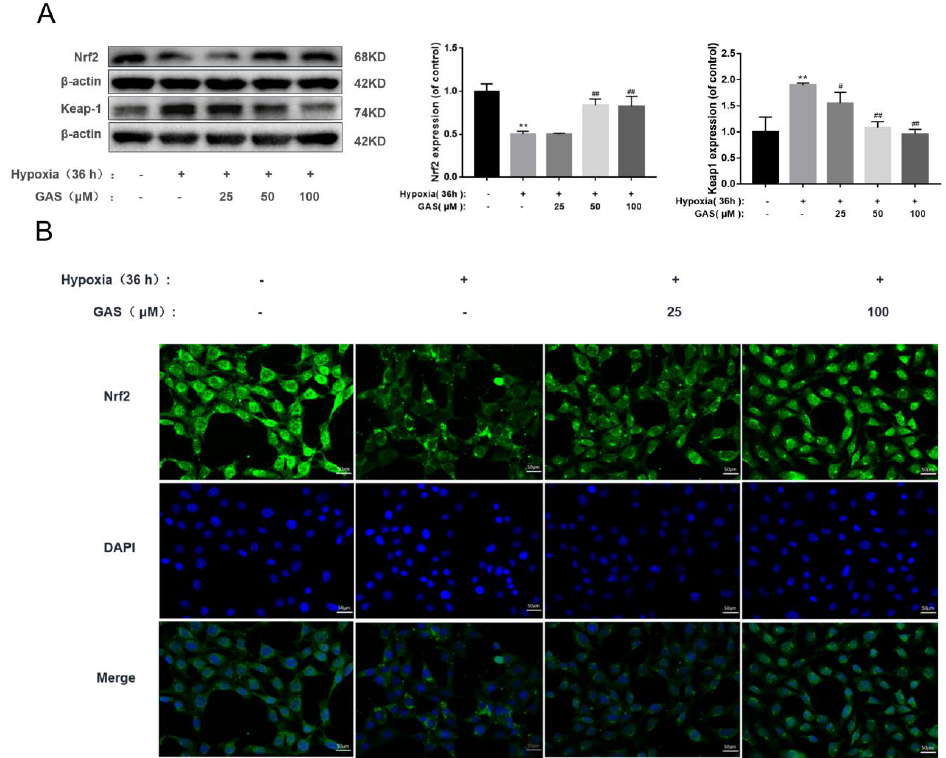
Figure 5. GAS activates the Nrf2 signaling pathway to ameliorate hypoxic injury in HT22 cells ( A ), HT22 cells were incubated in a normal incubator (5% CO 2 , 37 ◦ C) with GAS for 1 h and then placed in a hypoxia incubator (5% O 2 , 5% CO 2 , 90% N 2 , 37 ◦ C) for 36 h, and then the protein levels of GPx4 and COX2 were detected by Western blot ( B ), Immunofluorescence microscopy images of Nrf2 in HT22 after hypoxia treatment in the presence, or absence, of GAS for 36 h, and cell nuclei were stained with 4,6-diamino-2-phenyl indole (DAPI, blue fluorescence). Mean fluorescence intensity values were calculated by Image J software ( n = 3). Magnification, ×400; scale bars, 25 µm. Results are presented as mean ± SD. ** p < 0.01, control versus hypoxia; # p < 0.05, ## p < 0.01, hypoxia versus hypoxia plus GAS.